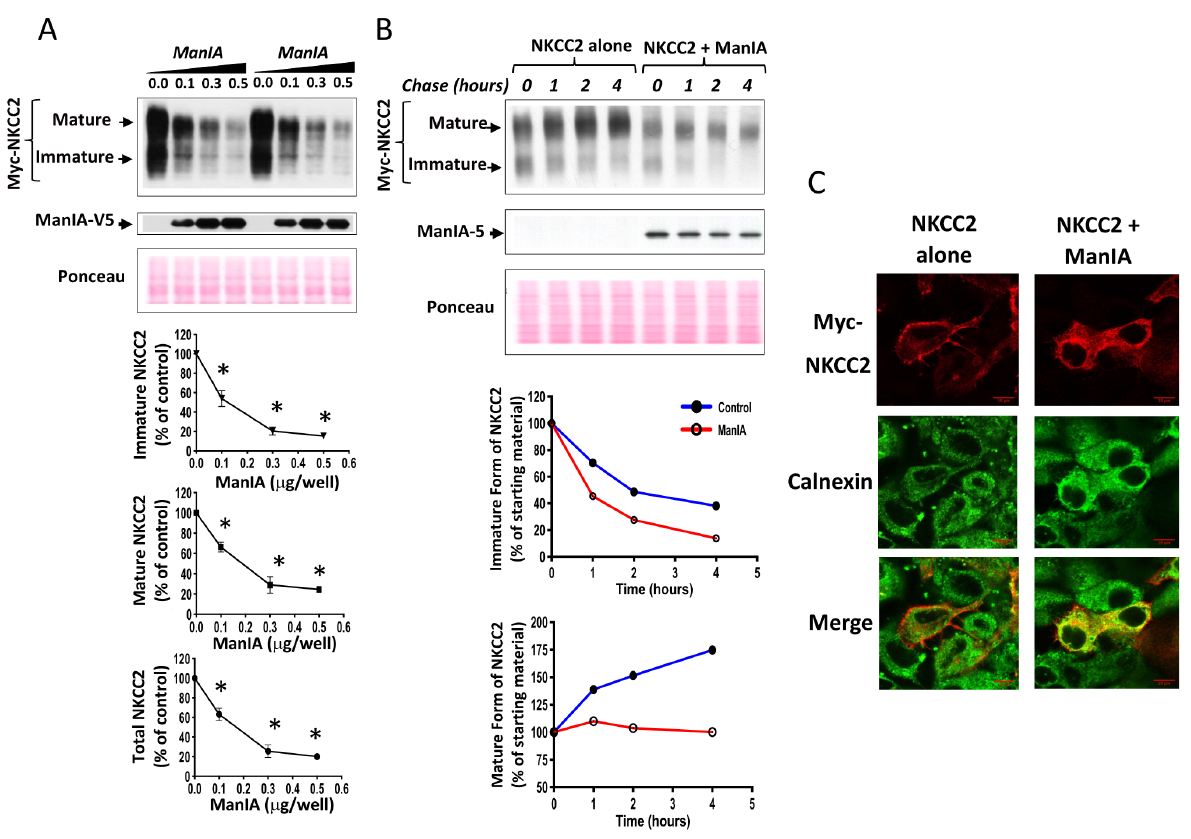
Figure 5. ManIA impairs NKCC2 maturation and stability independently of the expression system. ( A ) ManIA co-expression reduces Total NKCC2 protein abundance in a dose-dependent fashion. OKP cells were co-transfected with Myc-NKCC2 (0.1 μ g/well) and increasing amounts of ManIA (0.1–0.5 μ g/well) as indicated. NKCC2 proteins were detected by immunoblotting using Myc antibody (left panel). Lower panels, quantitation of steady state mature, immature, and total NKCC2 expression levels with or without ManIA co-expression. Data were normalized to the indicated loading control (Ponceau staining) from the same lane in each membrane and are expressed as percentage of control ± SE, *, p < 0.04 (n = 3), versus control. ( B ) Analysis of NKCC2 stability and maturation monitored by cycloheximide-chase upon ManIA expression. OKP cells were co-transfected with NKCC2 together with a control vector or ManIA-V5 construct. 16 h later, cell lysates were prepared at the indicated time points after cycloheximide treatment (100 μ M). Total protein extracts are subjected to SDS-PAGE and probed using anti-Myc and anti-V5 antibodies. The density of the mature and immature forms of NKCC2 proteins was normalized to the density at time 0. ( C ) Effect of ManIA on subcellular distribution of NKCC2. OKP cells transfected with Myc-NKCC2 alone or with ManIA-V5 were stained with mouse anti-Myc (Texas Red; red) and rabbit anti-calnexin (FITC; green). The yellow color in the merged image indicates colocalization of Myc-NKCC2 (red) with the ER marker (green).